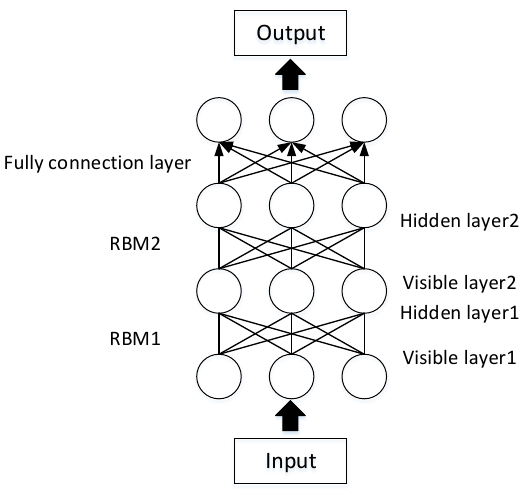
Figure 5. The structure of the